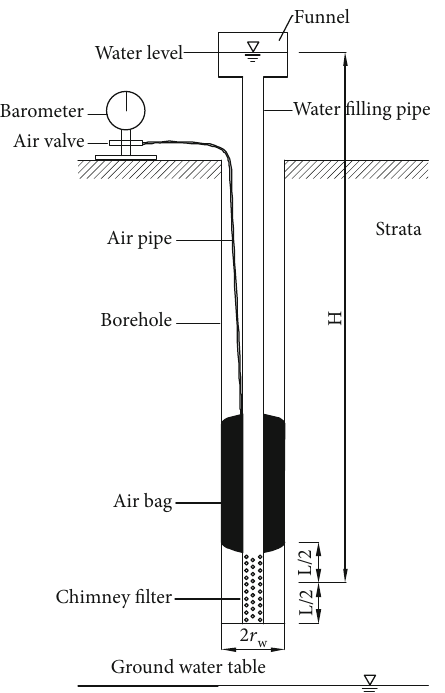
Figure 17: Water injection test pro fi le.